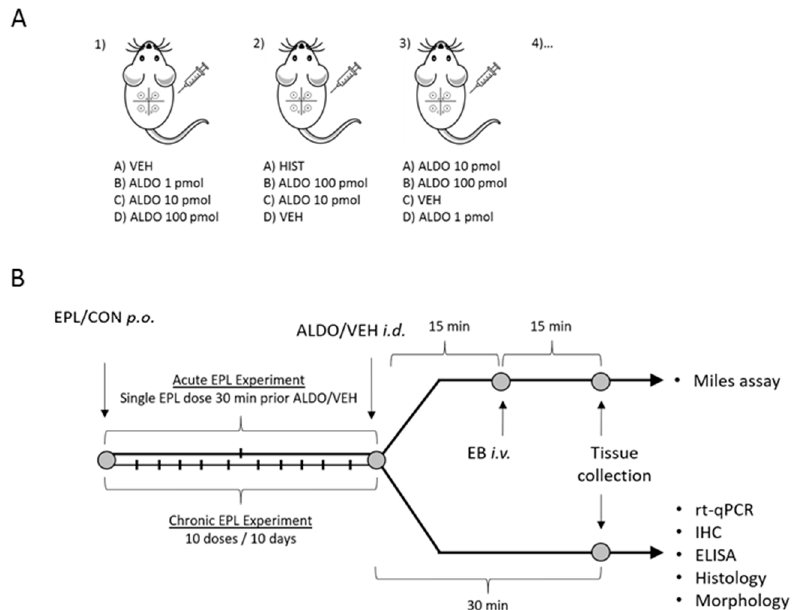
Figure 1. Experimental protocol; ( A ) intradermal injection of tested agents; ( B ) experimental timeline. ALDO—aldosterone; CON—eplerenone solvent; EB—Evans blue; ELISA—enzyme-linked immunosorbent assay; EPL—eplerenone; HIST—histamine; i.d.—intradermal; IHC—immunohistochemistry; i.v.—intravenous; p.o.—per os; rt-qPCR—real-time quantitative polymerase chain reaction; VEH—ALDO